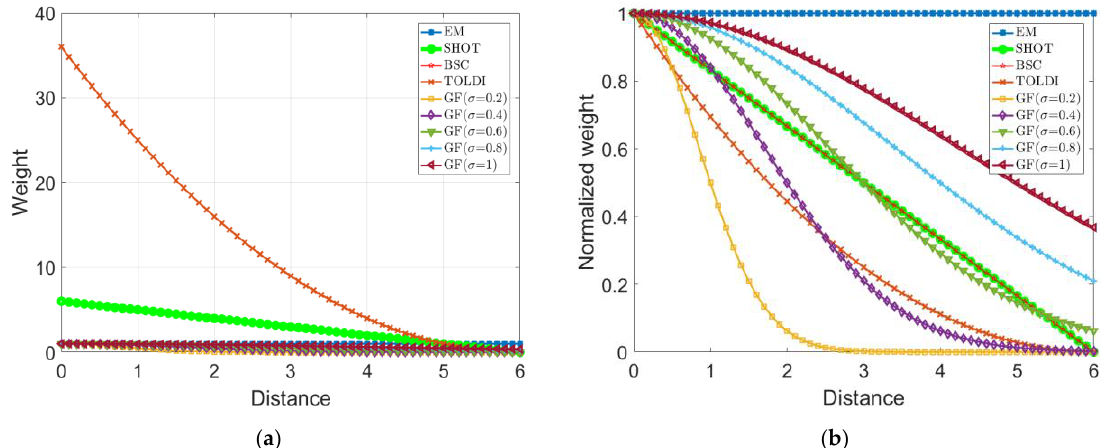
Figure 5. The weights calculated by the five weighting methods, including ( a ) weights, ( b ) normalized weights.